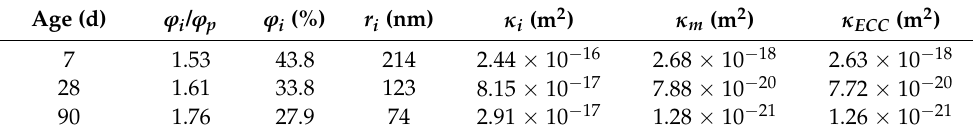
Table 4. Calculated permeability of